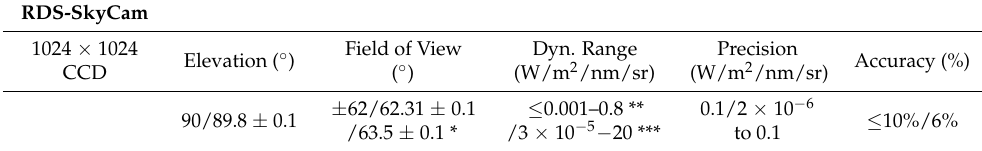
Table 3. RDS-SkyCam FM